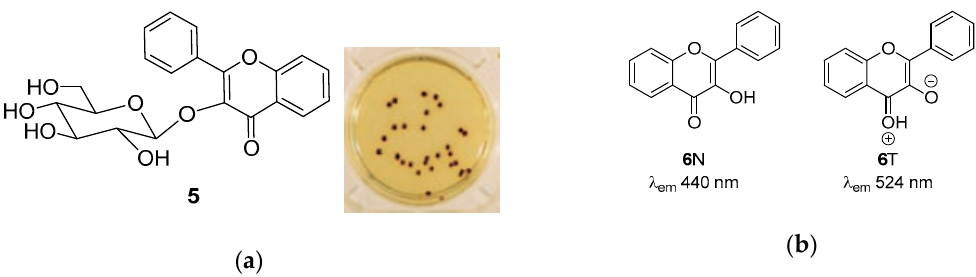
Figure 1. Chromogenic and fluorescence properties of 3HF 6, ( a ) Chromogenic substrate 5 and the produced dark brown colonies upon incubation and hydrolysis by Enterococcus faecium NCTC 7171 showing β -glucosidase activity. ( b ) 3-hydroxyflavone 6 N and its tautomer form 6 T, the species responsible for dual